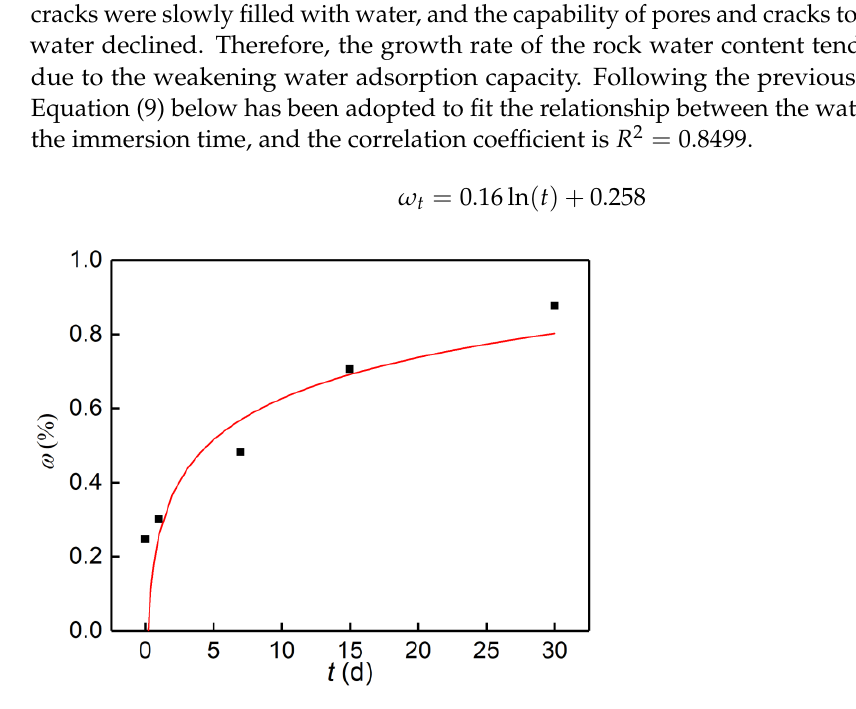
Figure 3. The relationship between the rock water content and the immersion time.